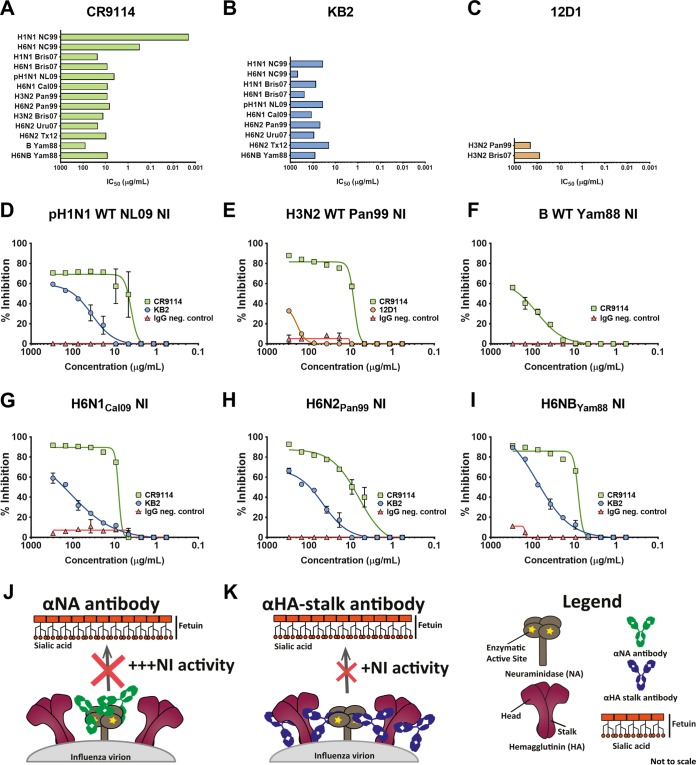
Anti-HA stalk antibodies interfere with NI activity in ELLA assays. (A) ELLA IC50 values for broadly reactive pan-HA stalk MAb CR9114 against H6NX and wild-type viruses. (B) ELLA IC50 values for broadly reactive group 1 MAb KB2 as measured with H6NX and wild-type viruses. (C) NI against H3N2 viruses in the presence of H3 stalk-reactive MAb 12D1. (D to I) Representative NI data from various H6NX and wild-type viruses in the presence of MAb CR9114, MAb KB2, or MAb 12D1 or an IgG negative-control MAb were plotted and fitted to nonlinear regression curves. (J and K) The data shown explain the potential mechanism of anti-HA stalk antibodies interfering with NI activity. (J) Anti-NA antibodies robustly interfere with neuraminidase activity by directly binding to NA and inhibition/shielding of the enzymatic site. (K) Anti-HA stalk antibodies bind to membrane-proximal sites on the HA and, via steric hindrance, indirectly shield the enzymatic site of NA and thus interfere with neuraminidase activity. However, this interference seems less robust than the inhibition from anti-NA antibodies.